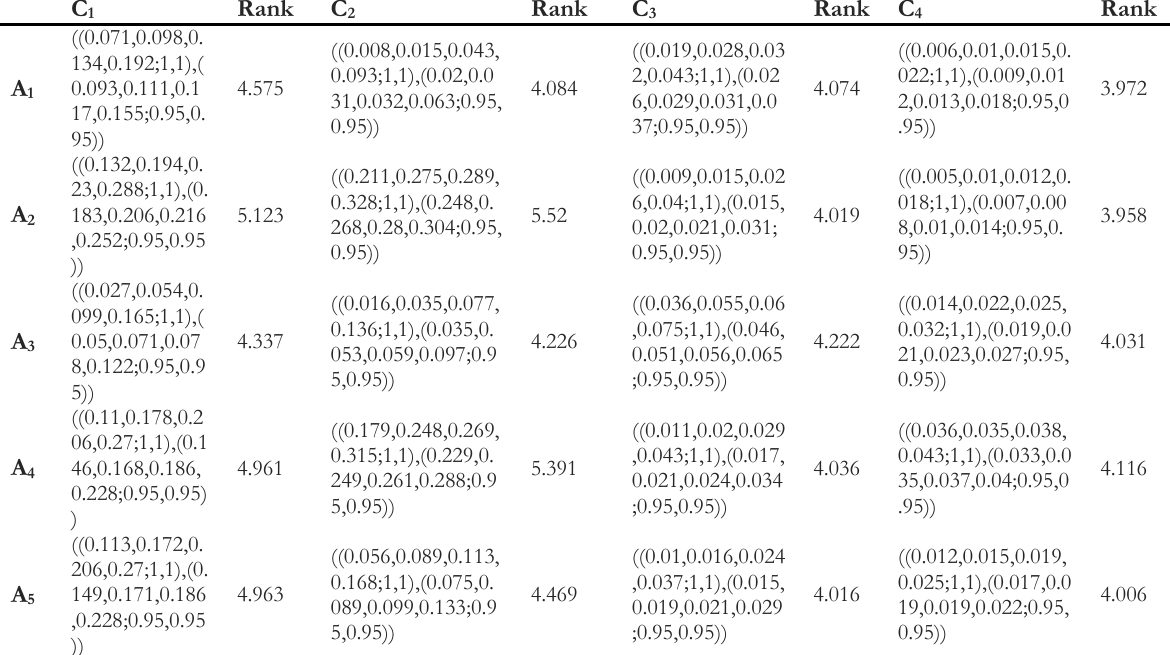
Table 5. Integrated decision